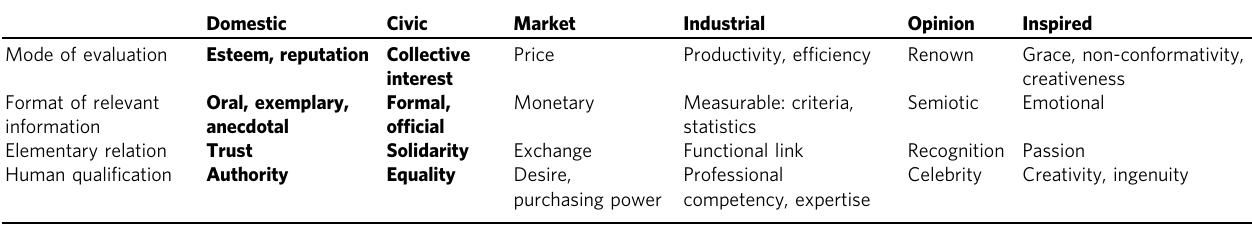
Table 1 Orders of worth (based on Boltanski and Thévenot, 1999, p.